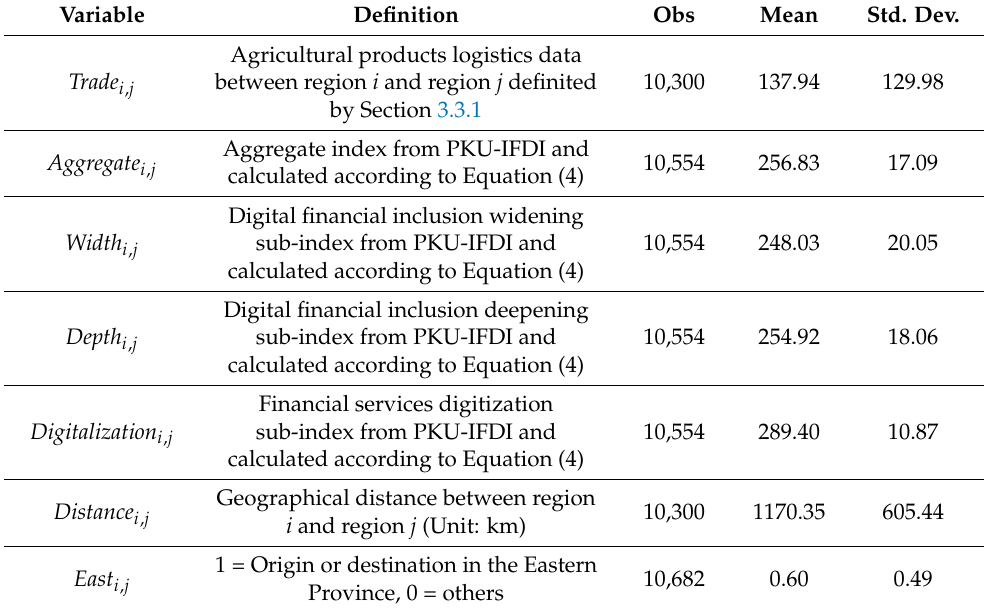
Table 1. Variables’ definitions and descriptive statistics.